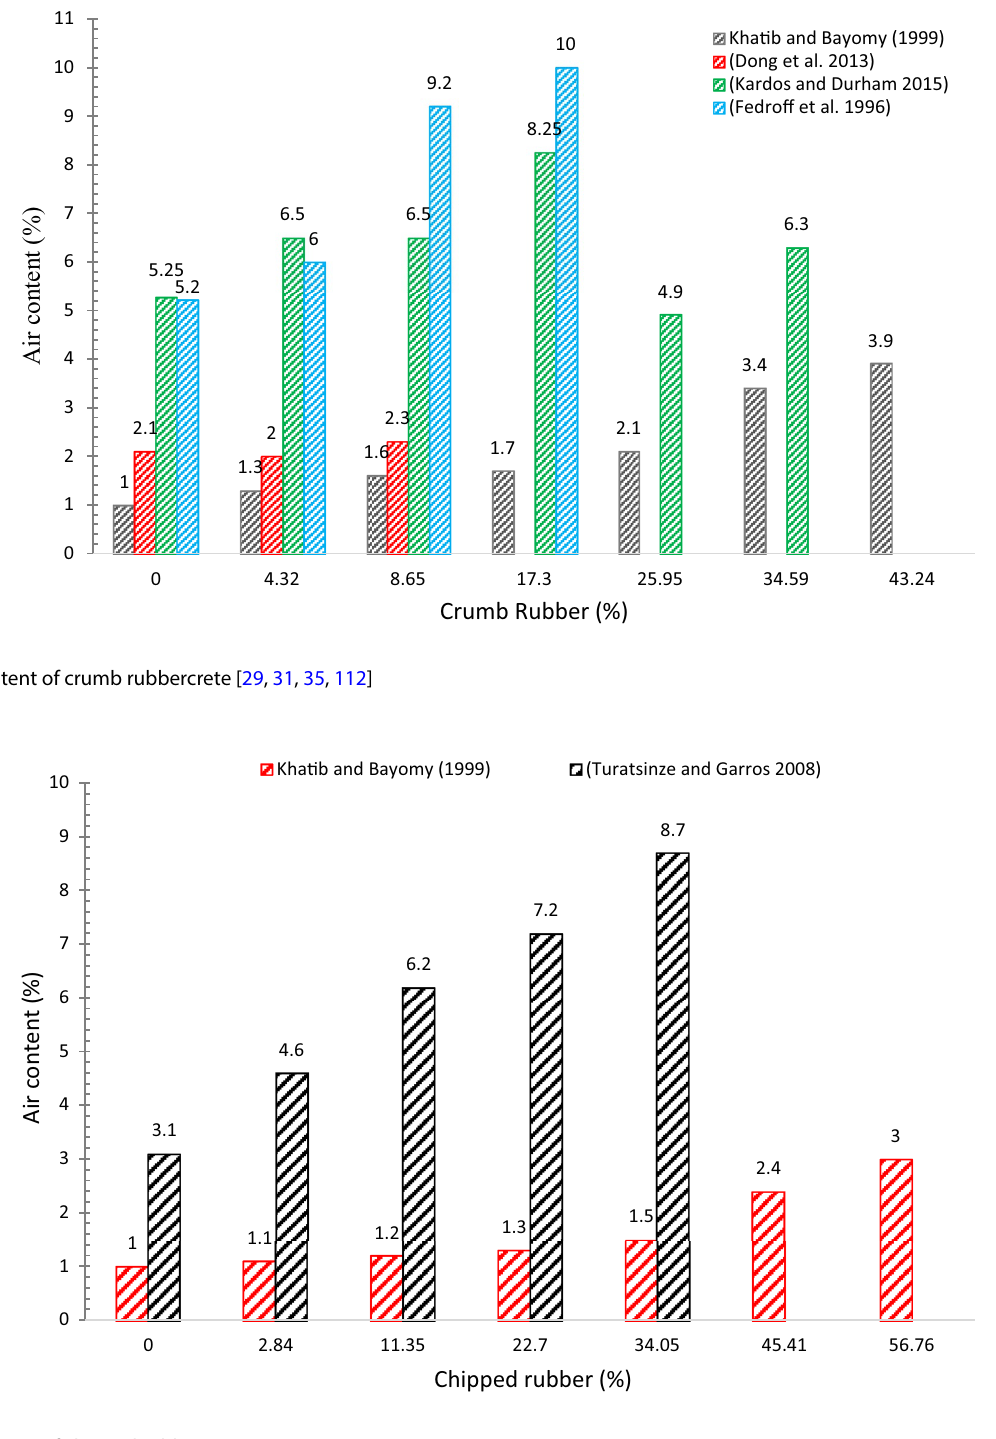
Fig. 5 Air content of chipped rubbercrete [35,